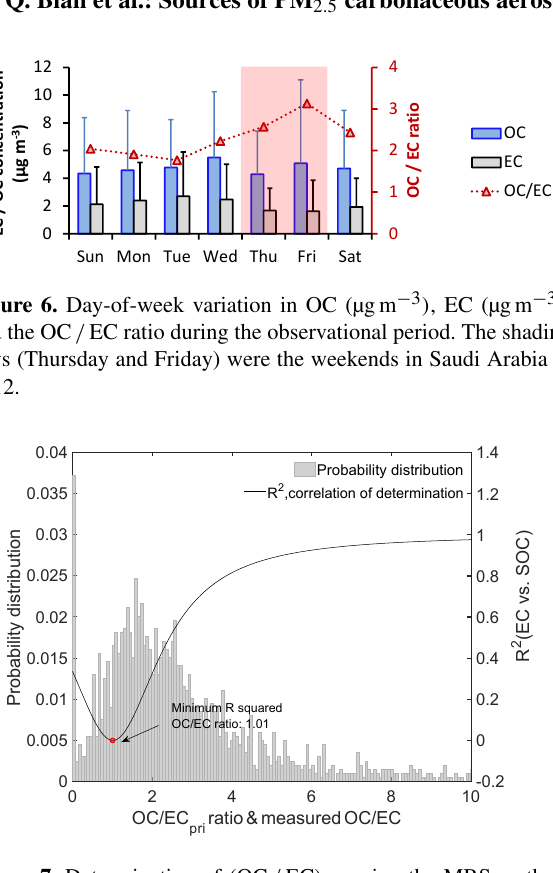
Figure 7. Determination of (OC / EC) pri using the MRS method. The black curve is the coefficient of determination ( R 2 ) between SOC and EC as a function of the assumed primary OC / EC ratio. The grey shaded area represents the probability distribution of the measured OC / EC ratios. The turning point (red circle) in the curve gives the best-fit primary emission ratio (OC / EC) pri